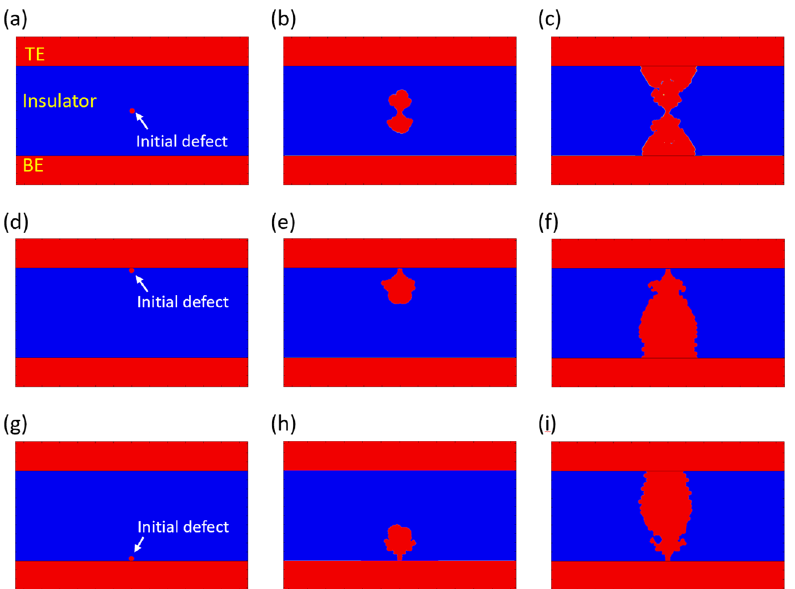
Figure 5. Evolution of conductive filament during voltage ramp-up when the initial defect is ( a – c ) at the middle position, ( d – f ) adjacent to the top electrode, and ( g – i ) adjacent to the bottom electrode. TE denotes the top electrode and BE denotes the bottom electrode. The insulator thickness is 5 nm.